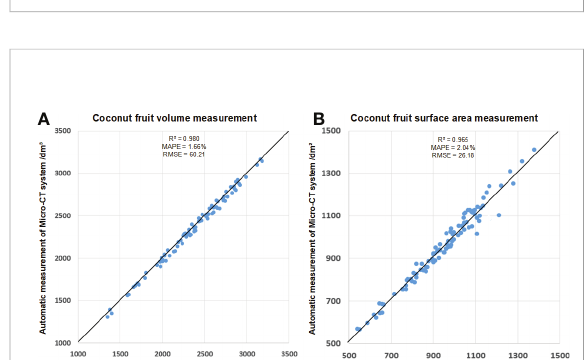
FIGURE 8 The 3D point cloud model of coconut fruit and seeds, and the sectional views in three directions. (A) Result for a coconut fruit sample. (B) Result for a coconut seed sample.